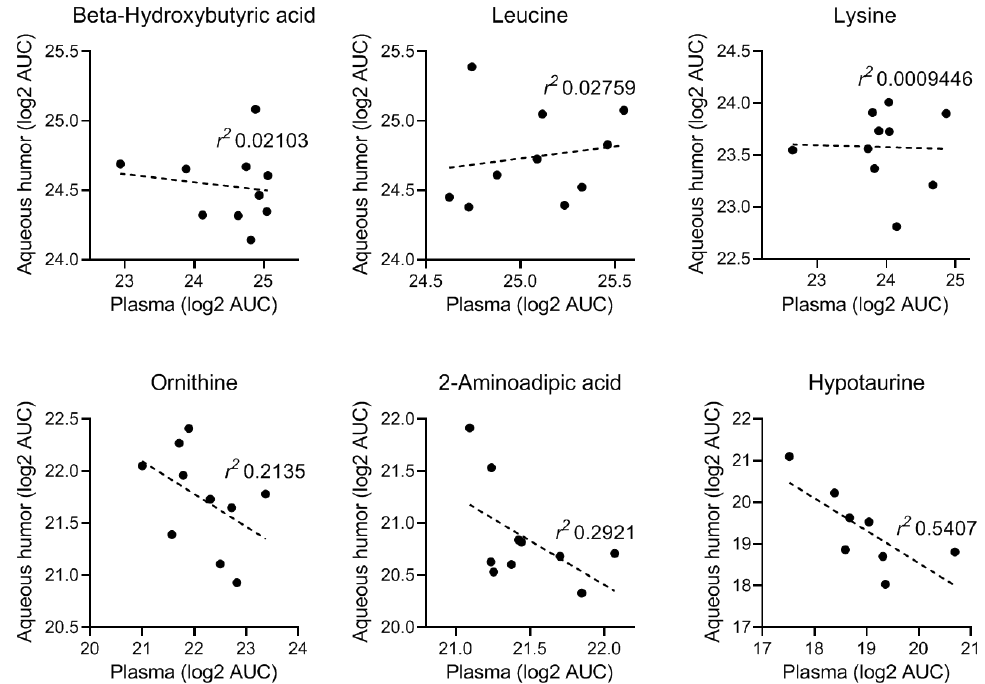
Figure 3. Representative metabolites that showed low or inverse correlation between their aqueous humor and plasma levels as measured by GC-MS. Data shown as log 2 AUC values (arbitrary units) acquired in aqueous humor and plasma samples ( n = 10 each).